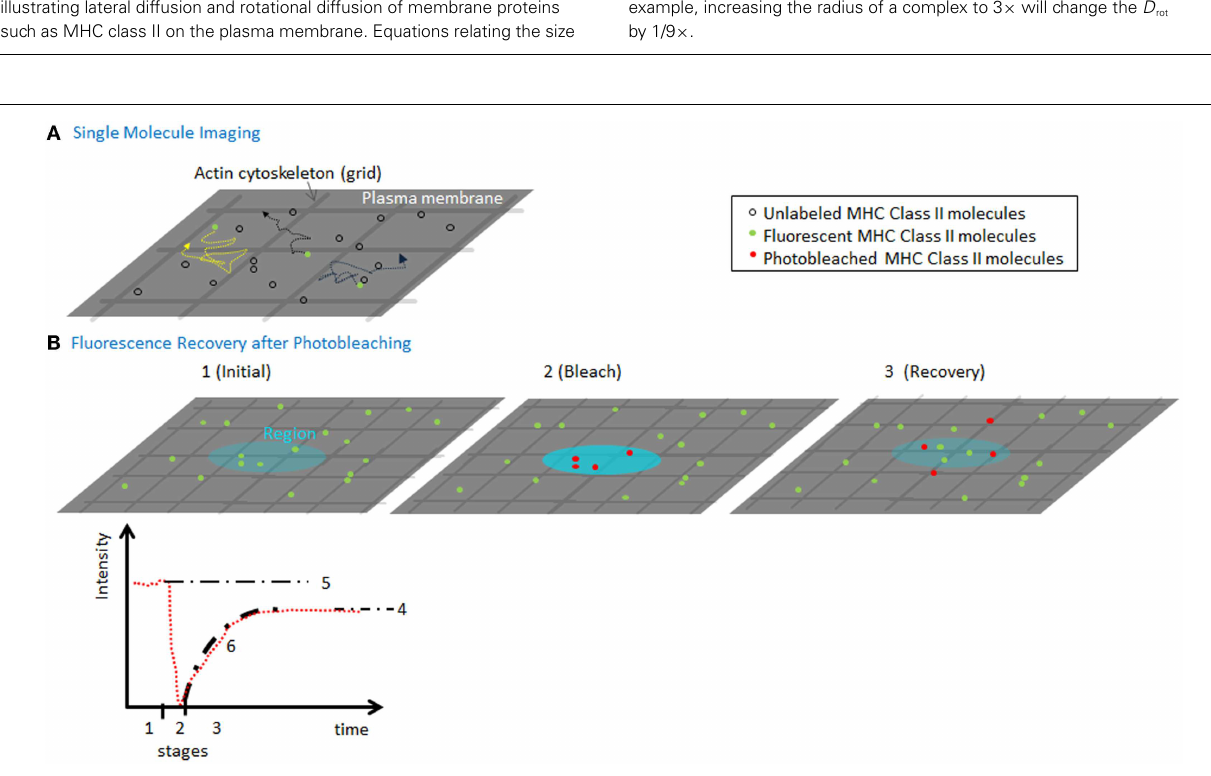
FIGURE 2 | Measuring MHC lateral diffusion . (A) A diagram of single molecule imaging. A small fraction of molecules is labeled to ensure that only single molecules are visualized. High-speed cameras capture the position of the molecules, which can be used to track the speed and identify obstacles such as actin cytoskeleton forming “corrals.” By imaging at millisecond speeds can capture the tracks of molecules in between and during hops between actin corralled regions of the membrane. (B) A diagram of a FRAP experiment (1) using a low-power, attenuated laser, a region (~300nm or larger) of the membrane is monitored for fluorescence of molecules using various detection